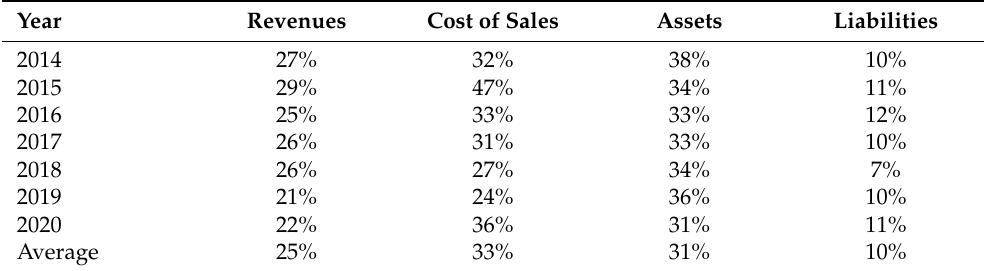
Table 7. Percentage share of conventional and renewable energy in individual items of Tauron group’s consolidated financial statements, 2014–2020.